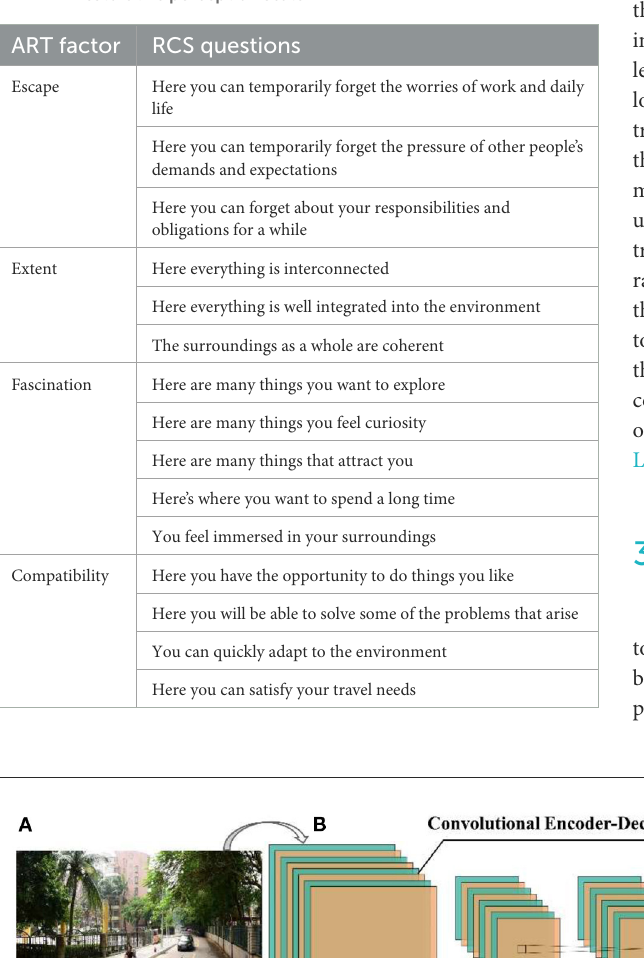
TABLE 1 Restorative perception scale.